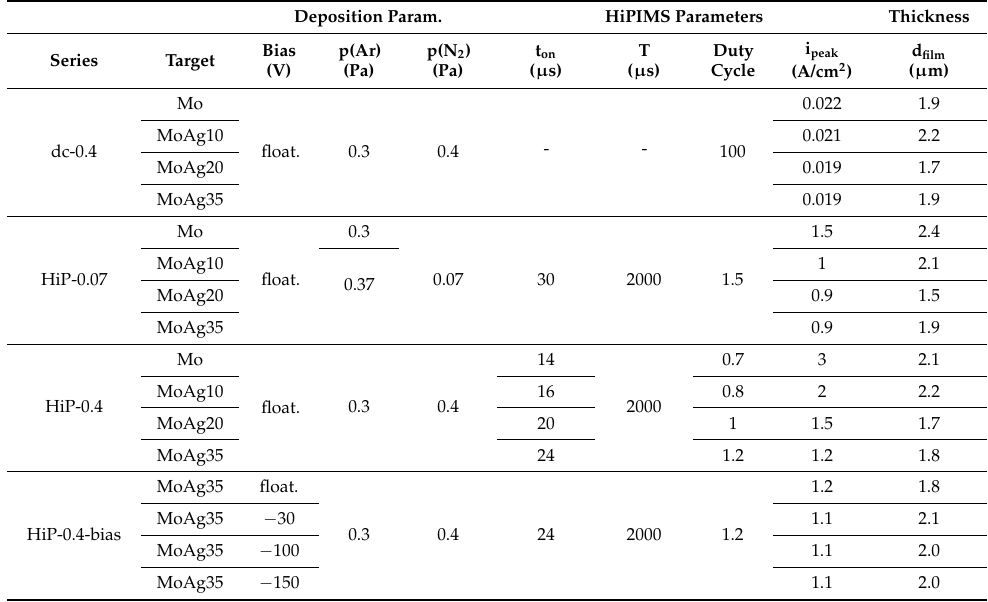
Table 1. Deposition parameters of the 4 series and the coating thickness d film of the prepared films. Deposition Param. HiPIMS Parameters Thickness